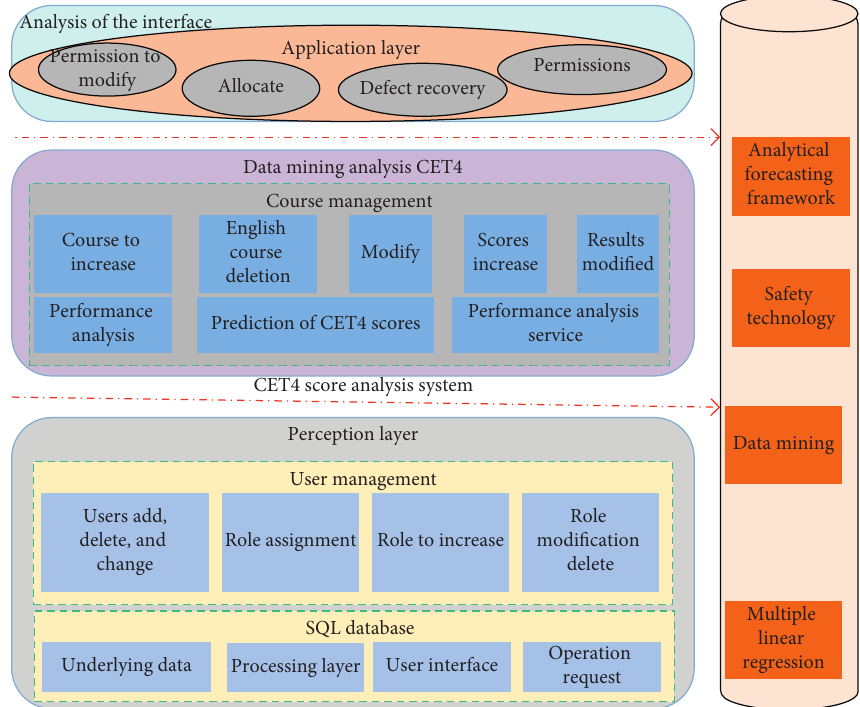
Figure 1: Block diagram of four-level achievement analysis and prediction based on multiple linear regression